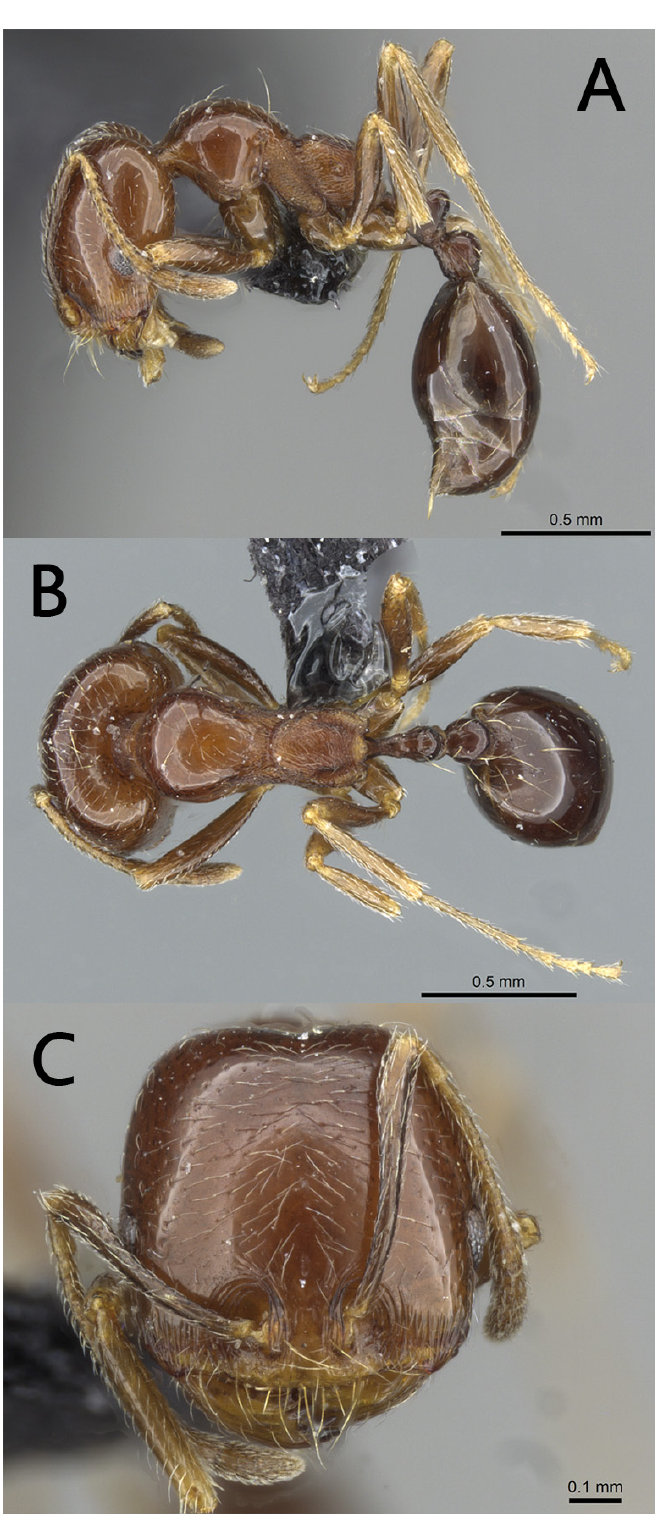
Fig. 12. Trichomyrmex robustior (Forel, 1892), lectotype, worker (CASENT0101849). A . Body in profile. B . Body in dorsal view. C . Head in full-face view (photos: Zach